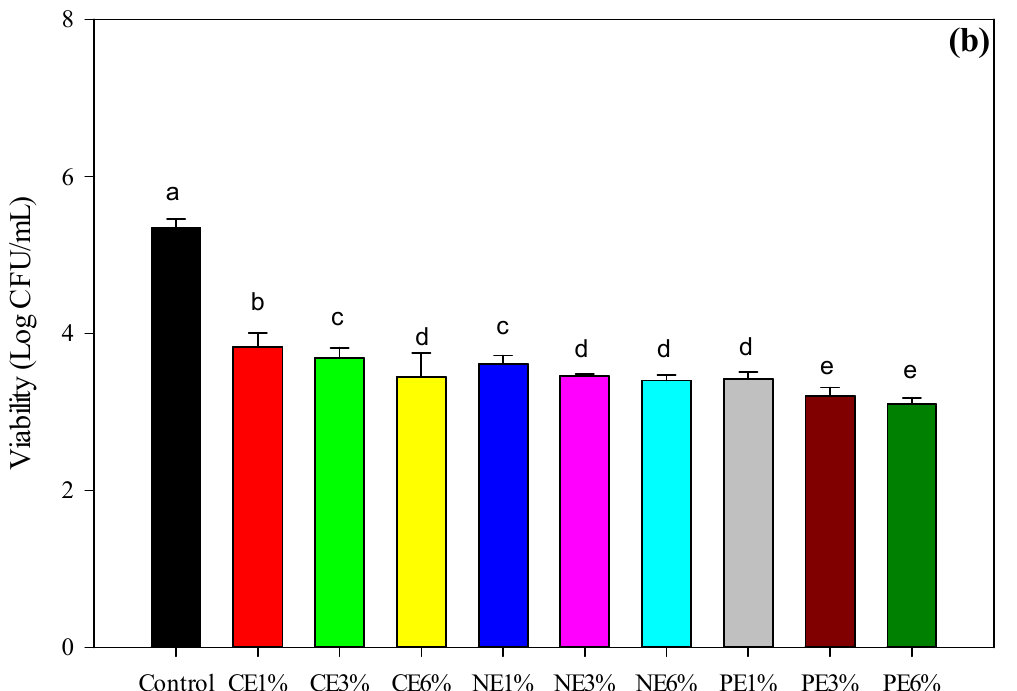
Figure 4. Effectiveness of LDPE film treated with cold plasma containing CE-, NE-, and PE-stabilized MFEO. ( a ) antimicrobial assay against S. aureus , ( b ) antimicrobial assay against E. coli . a–e The values with different superscripts are significantly different at p < 0.05. The error bars represent the standard deviations ( n = 3).